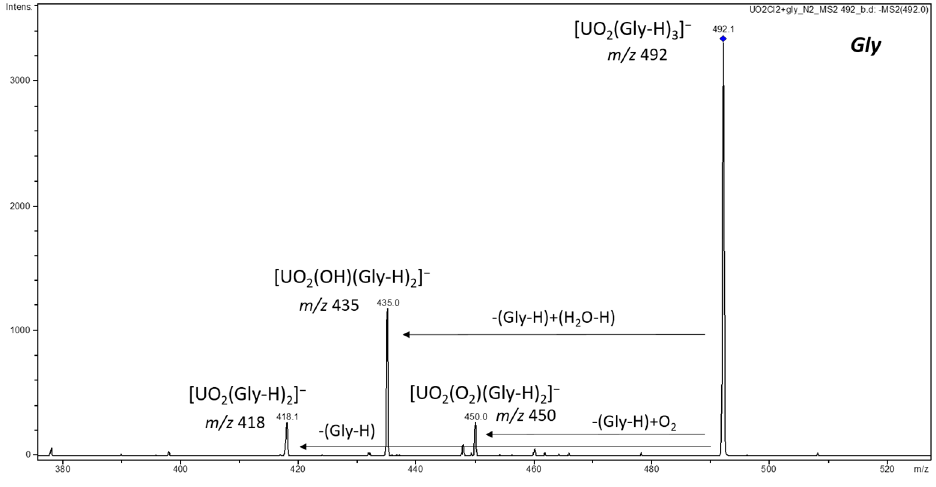
Figure 5. CID mass spectrum of [UO 2 (Gly-H) 3 ] −